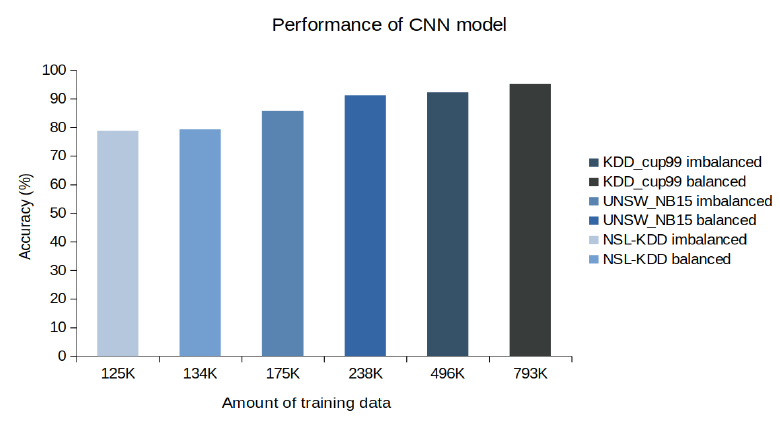
Figure 6. Impaction of data amount in case of